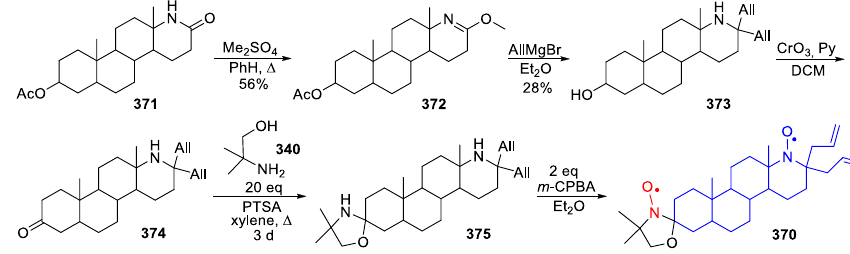
Figure 15. Crystal structure of biradical 365 . ( a ) 2D, ( b )